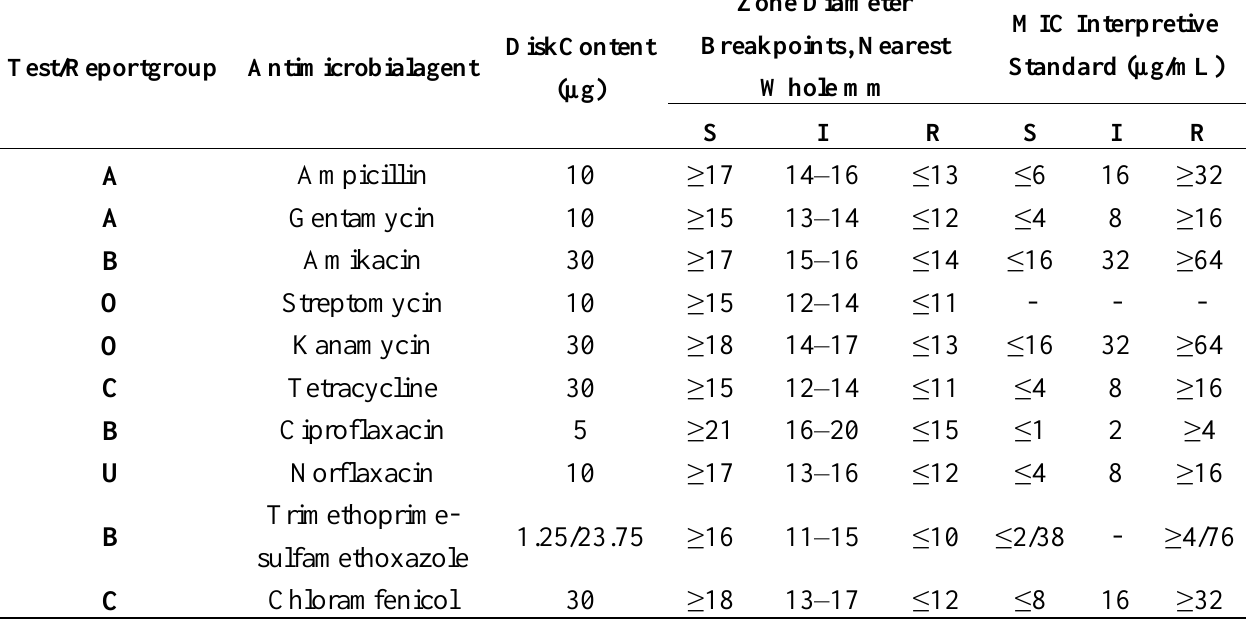
Table 2. Minimal Inhibitory Concentration (MIC) Breakpoints for Enterobacteriaceae. Source: (CLSI